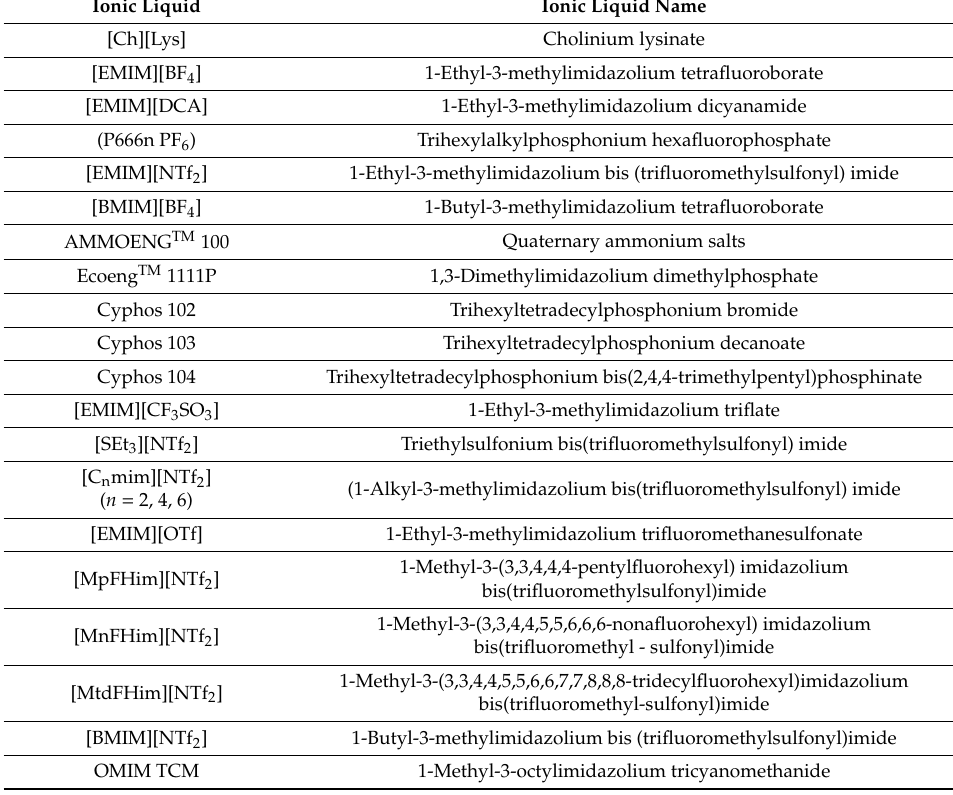
Table 2. Names and abbreviations of the ionic liquids used in this